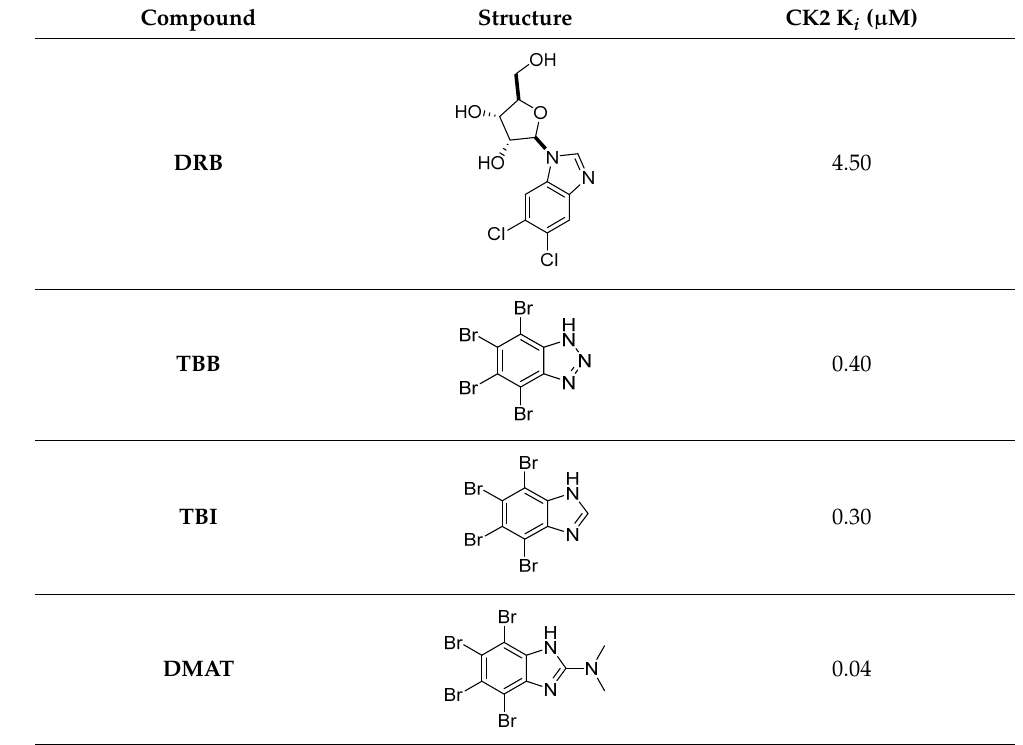
Table 1. Comparison of the structures and activities of CK2 ATP-competitive inhibitors DRB, TBB, TBI and DMAT [60,82].